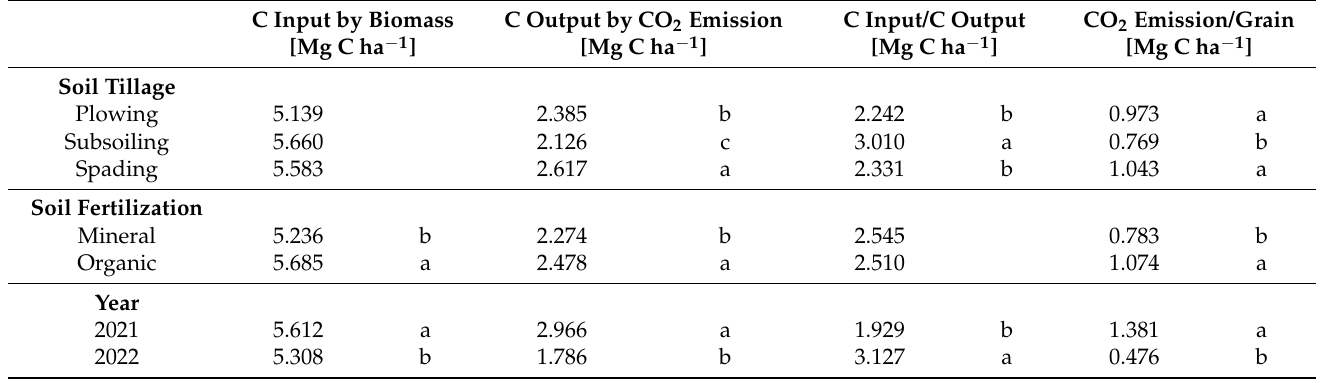
Table 1. The carbon balance in the wheat crop and the effects related to soil tillage practice, fertilization source and year. Different letters for each main effect indicate statistically significant differences according to the LSD test ( p < 0.05). No letters mean that differences between the means were not significant ( p > 0.05).